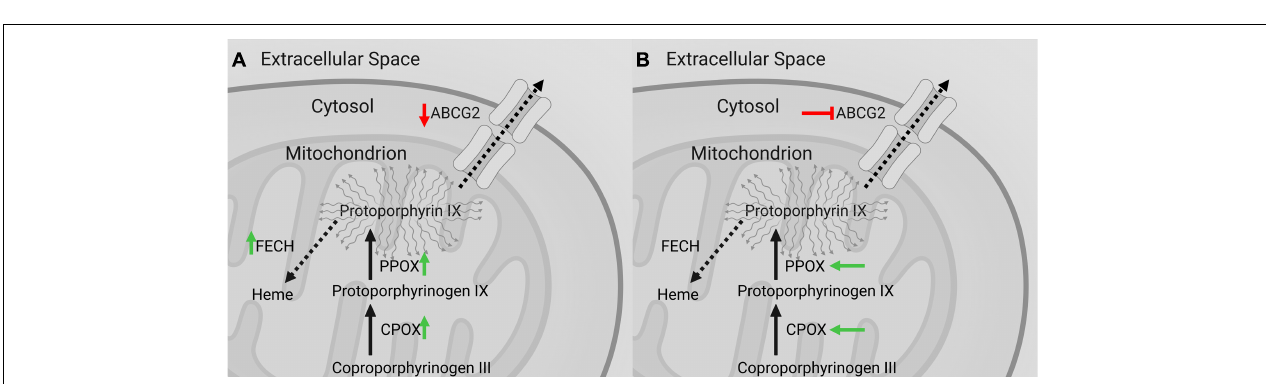
FIGURE 6 | Observed effects on intramitochondrial heme biosynthesis factors in gliomas with visible 5-ALA fluorescence and promising pharmacological targets to optimize fluorescence visualization. (A) According to our study, heme biosynthesis pathway activity in general is enhanced in gliomas with visible 5-ALA fluorescence with upregulation of PpIX generating factors (CPOX and PPOX; green arrow ) and decreased ABCG2 mediated PpIX efflux ( red arrow ) outweighing the also increased further metabolization of PpIX to heme by FECH ( green arrow ). (B) Intramitochondrial heme biosynthesis factors thus constitute promising pharmacological targets to optimize intraoperative 5-ALA fluorescence visualization of usually non-fluorescing tumor tissues such as low-grade gliomas. In this sense, enhancement of CPOX and PPOX ( green arrows ) as well as inhibition of ABCG2 ( red symbol ) represent promising candidates for future investigations. For example, the tyrosine kinase inhibitor lapatinib constitutes a potent suppressor of ABCG2 with an overall favorable safety profile in clinical